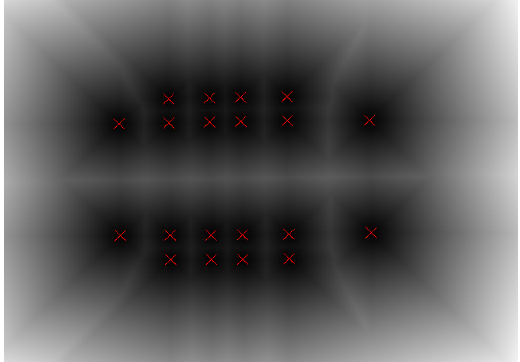
Figure 4. DT image. The distances are gray-level coded: the larger the distance the lighter the tone. The red cross are the feature points of the cutter holder.